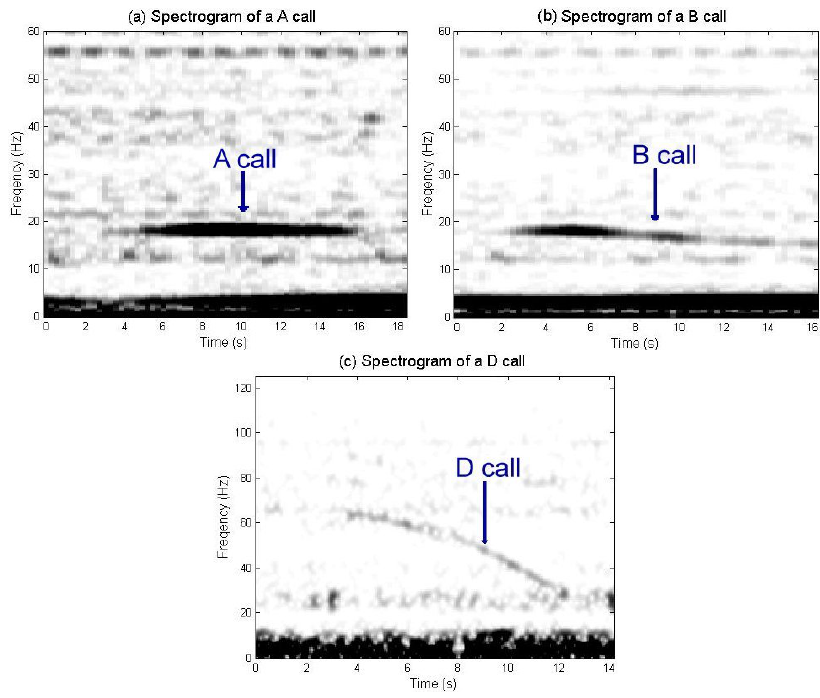
Figure 1. Spectrogram of an A call ( a ), a B call ( b ), and a D call ( c